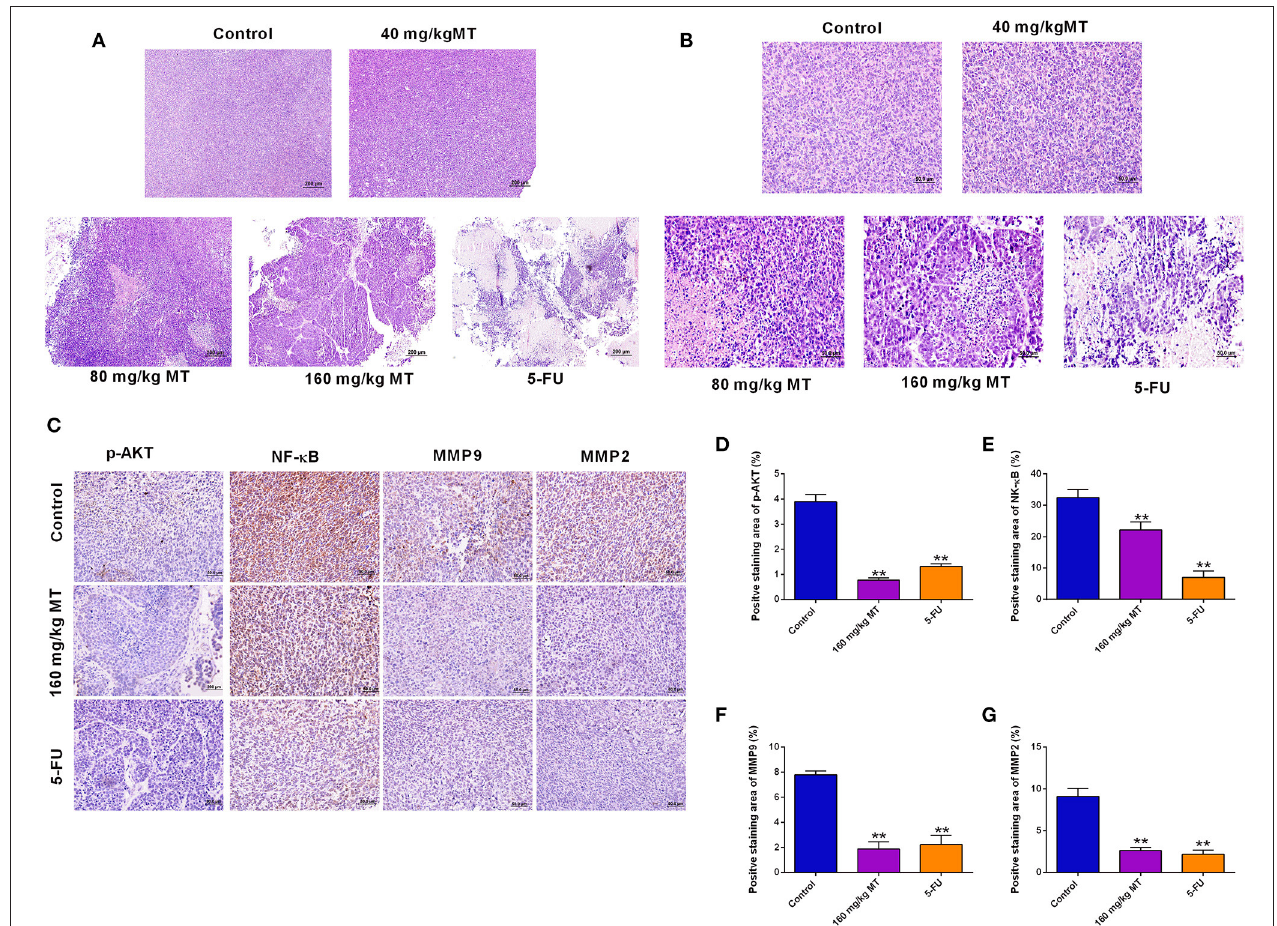
FIGURE 6 | Pathological morphology and relative protein expressions in the tumor tissues. (A,B) HE staining of tumor of nude mice from different treatment groups, original magnification: (A) 10 × (B) 40 × . (C) Immunohistochemistry for p-Akt, NF- κ B, MMP9, and MMP2 in tumors of nude mice in different groups, original magnification: 40 × . (D–G) The results of the ratio of positive staining of p-Akt (D) , NF- κ B (E) , MMP9 (F) and MMP2 (G) are analyzed and Quantified by ImageJ. N = 5. ** P < 0.01 compared to the corresponding control